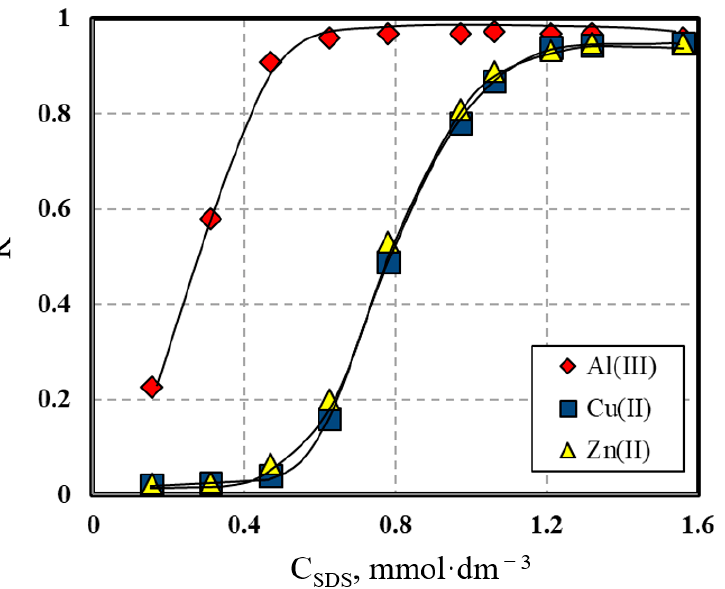
Figure 3. Influence of the SDS concentration on the efficiency of simultaneous ion flotation of Al(III), Cu(II), and Zn(II): c 0 = 0.15 mmol dm − 3 , pH = 3.0.